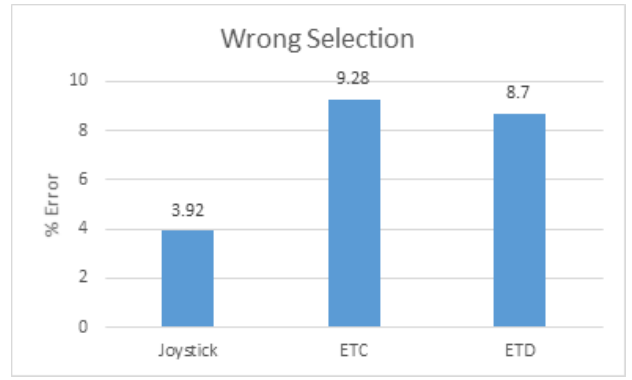
Figure 35. Analysing error in the flight simulator.